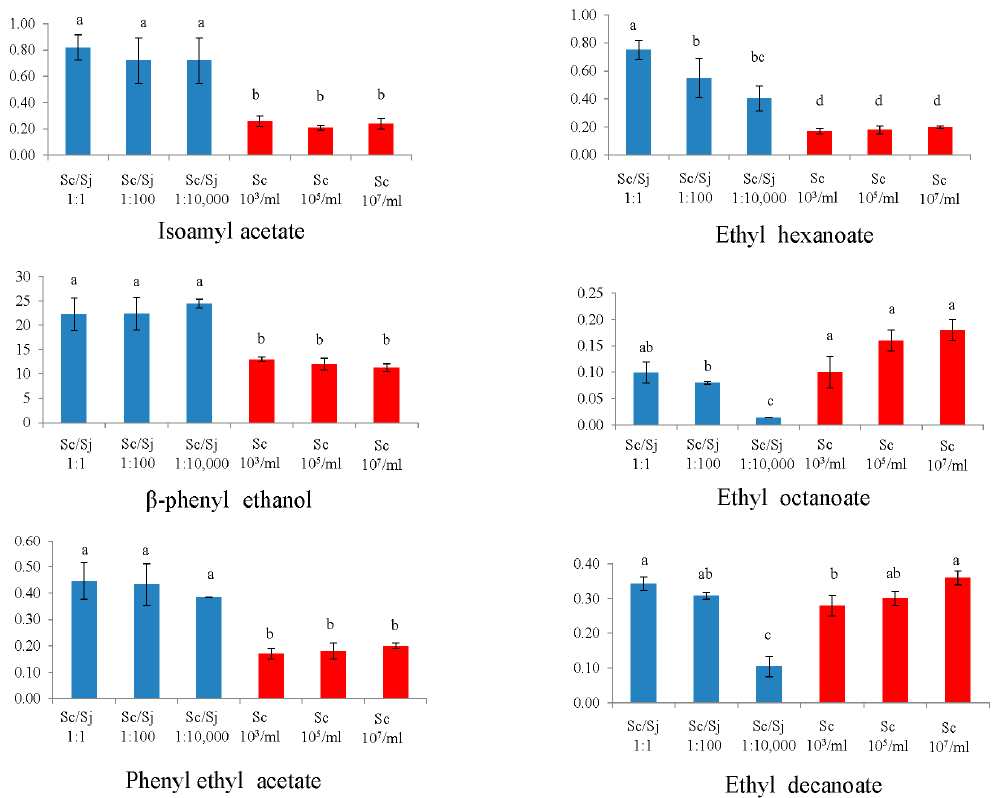
Figure 2. Volatile compounds of wines obtained with S. cerevisiae EC1118 in pure cultures (Sc) and mixed cultures with S. japonicus #13 (Sc/Sj). Data are means ± standard deviations of two independent experiments, each carried out in duplicate. Values displaying different letters (a, b, c, d) are significantly different according to the Duncan test (0.05%).